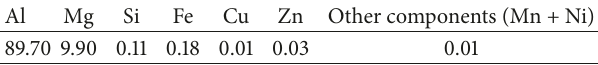
Table 1: Chemical composition of Al-10Mg